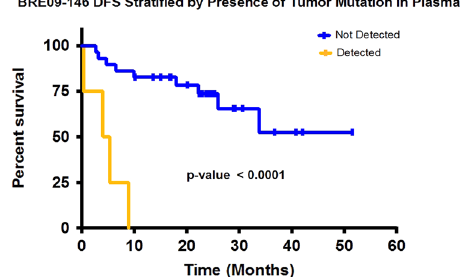
Fig. 5 Kaplan – Meier plot: disease-free survival strati fi ed by presence of tumor mutation in plasma. Four patients from this study who had mutation identi fi ed from plasma samples relapsed rapidly (0.3, 4.0, 5.3, and 8.9 months). The yellow line represents patients with detectable ctDNA in plasma. The blue line represents patients with no detectable ctDNA in plasma.The difference in median DFS between patients with detectable ctDNA vs. those without was statistically signi fi cant ( p < 0.0001, median DFS: 4.6 mos. vs. NR; HR = 12.6, 95% CI: